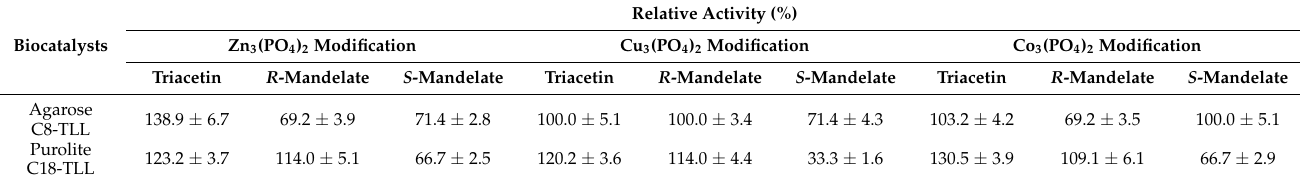
Table 2. Relative activity (calculated as the ratio activity of the modified biocatalyst/activity of the unmodified biocatalysts in percentage) of different TLL-based biocatalysts in the reaction of substrate hydrolysis under the defined conditions. Experiments were conducted as described in